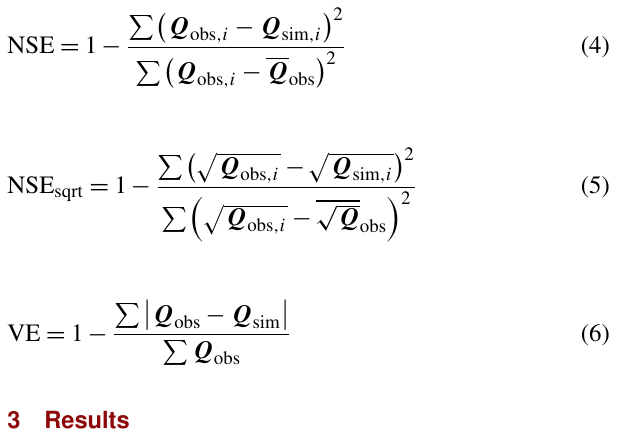
Figure 3. Comparison of the stream network extraction for all DEMs on a random zone of